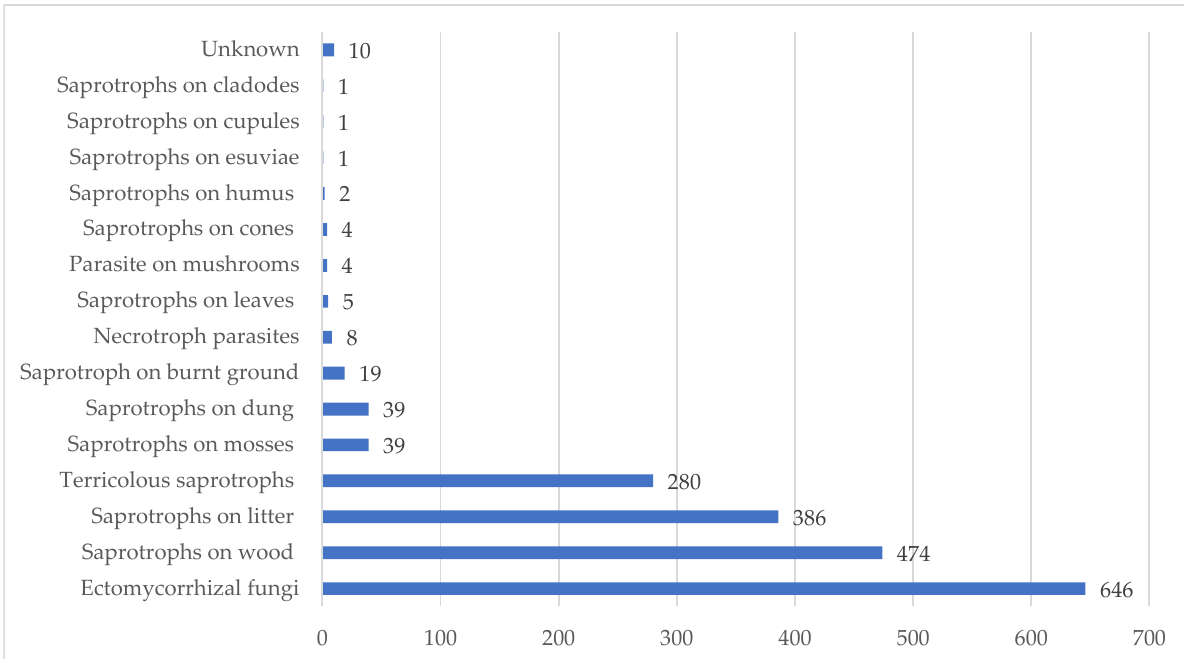
61 of 64 Figure 2. Number of taxa per provinces. The taxa listed in Table 1 belong to 15 ecological categories. For ten taxa, the ecolog- ical category to be assigned is unclear and is therefore listed as Unknown (UNK). Ectomycorrhizal fungi (637 taxa) are the most represented ecological category (Fig- ure 3), followed by saprotrophs on wood (484 taxa), saprotrophs on litter (386 taxa), ter- ricolous saprotrophs (279 taxa), saprotrophs on mosses (39 taxa) saprotrophs on dung (39